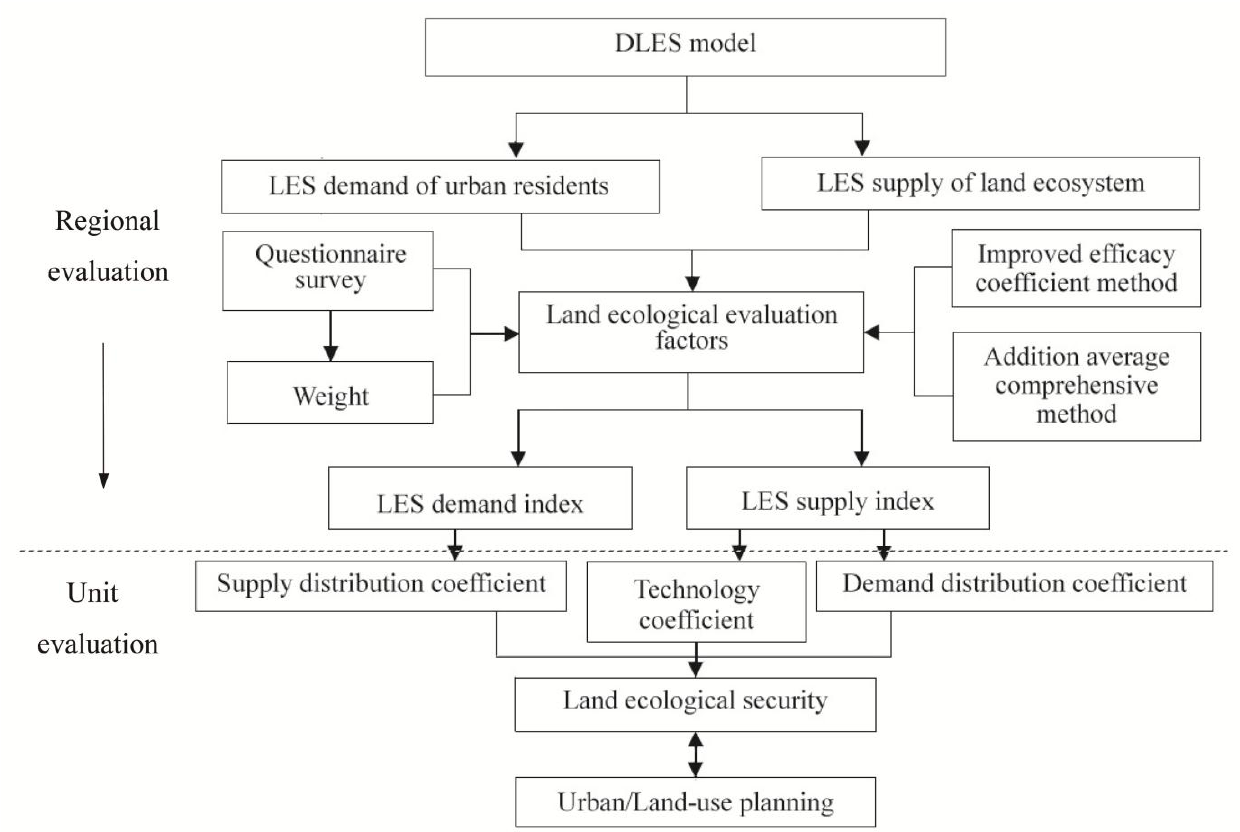
Figure 2. Framework of the DLES